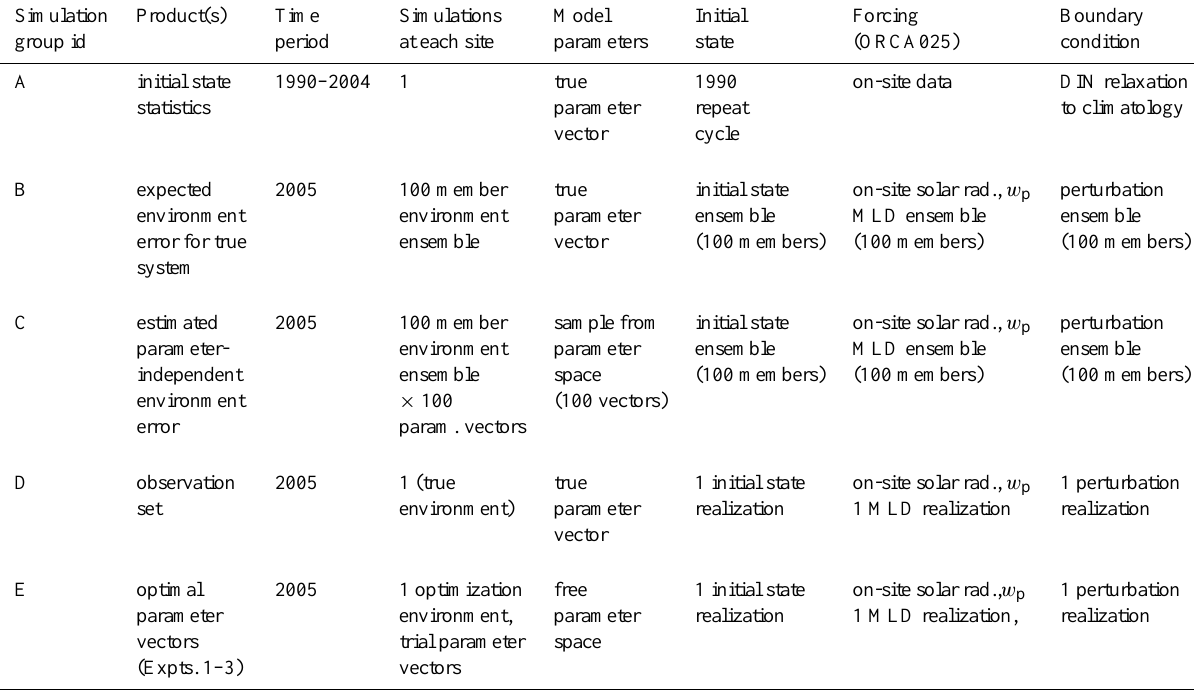
Table 2. Overview of 1-D plankton model simulations.